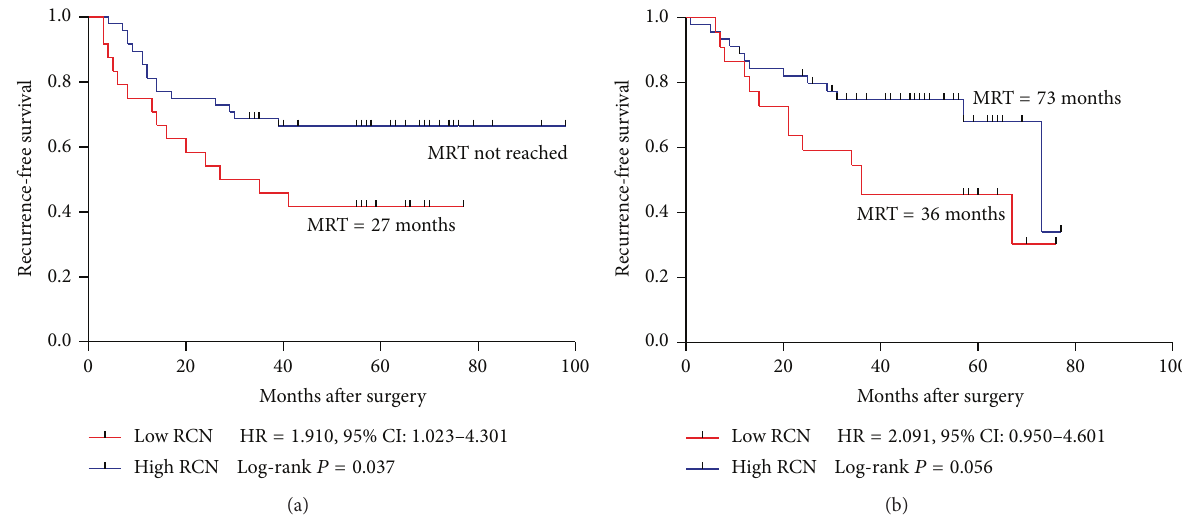
Figure 2: Kaplan-Meier survival curves of patients with stage III, IIIB, and IIIC disease receiving oxaliplatin-based chemotherapy. (a) RFS in colon; (b) RFS in rectum. MRT: median recurrence time.